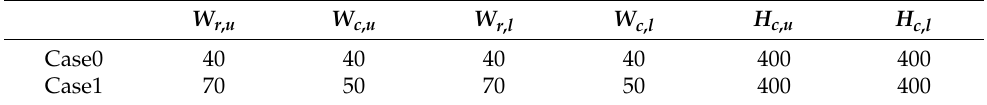
Table 1. Structural parameters of traditional double-layer microchannel sink (unit: µ m).